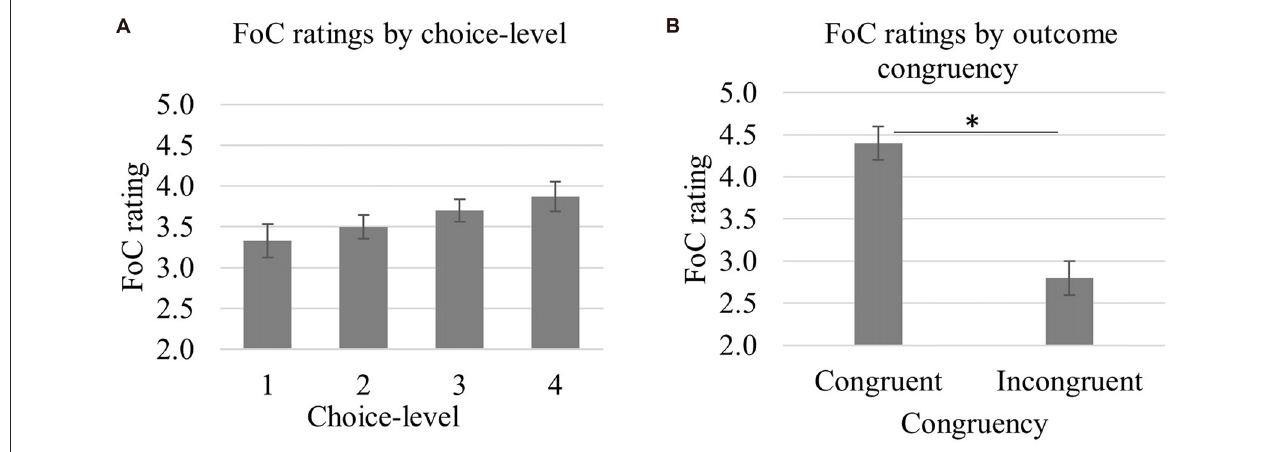
FIGURE 3 | Mean FoC ratings as a function of choice-level (A) and outcome congruency (B) . FoC ratings were significantly increased with increasing choice-level ( p = 0.027) and were higher for congruent compared to incongruent outcomes ( ∗ p < 0.001). Error bars represent standard error of the mean.